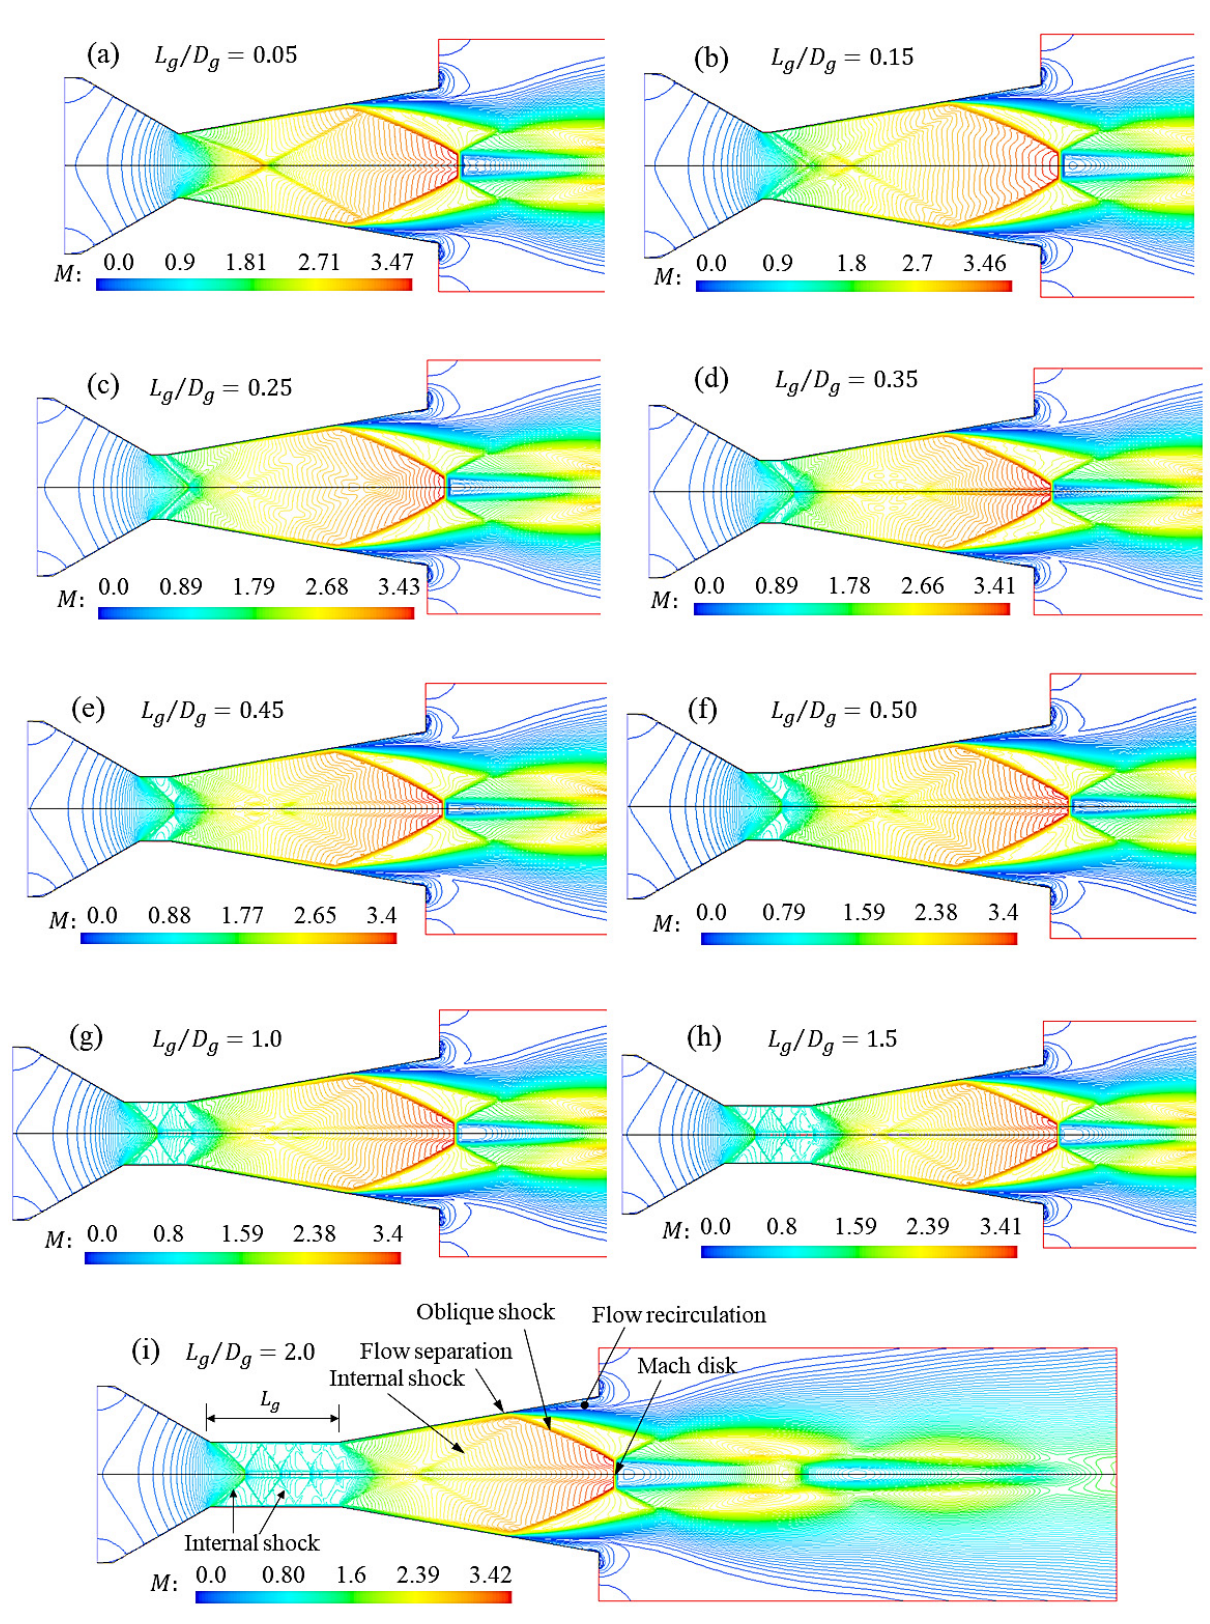
Figure 7. Flow field with presence of shock waves: Mach number contour lines. Conical nozzle throat length in the range 0.05 ≤ L g /D g ≤ 2. Source: